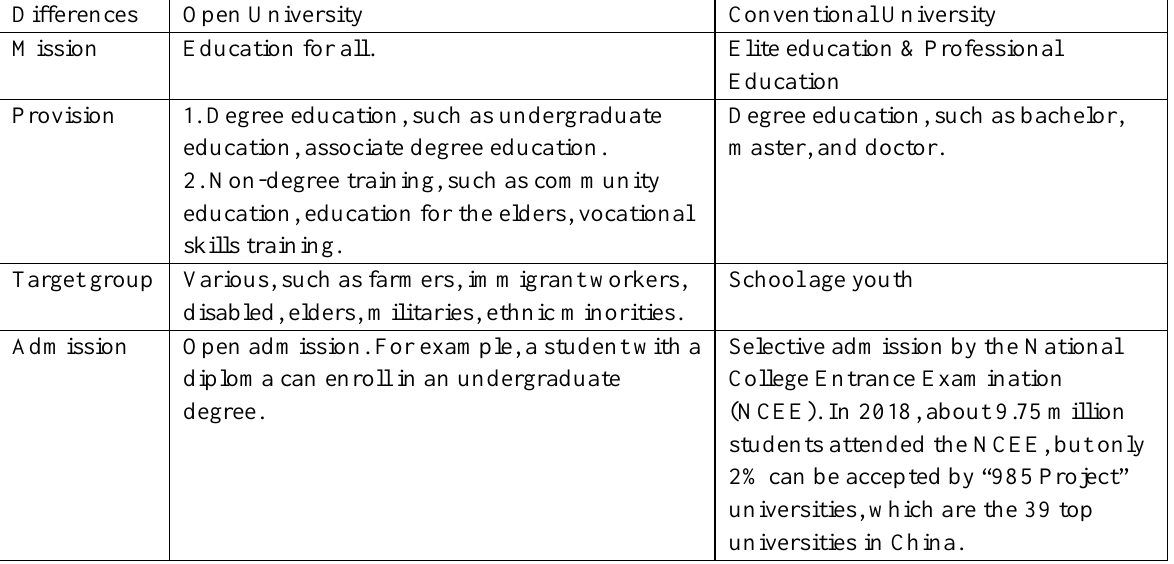
The Differences Between Open University and Conventional University in China Differences Open University